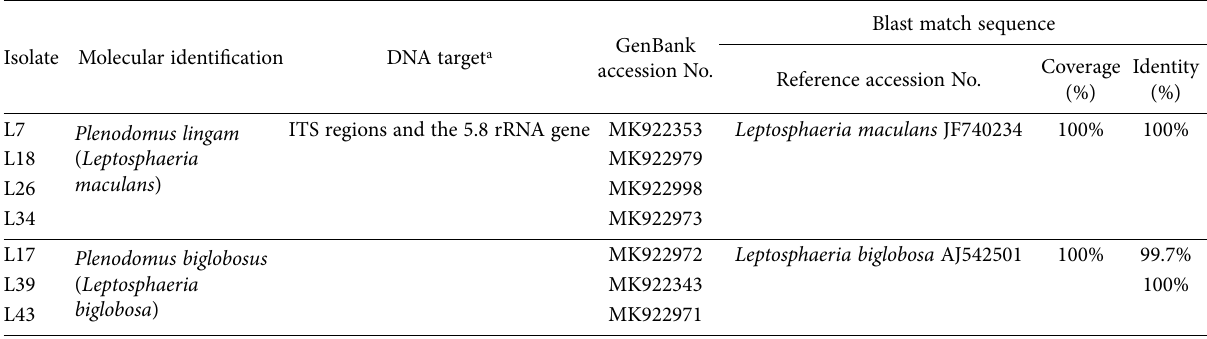
Table 2. Molecular identification and GenBank accession numbers of representative Plenodomus isolates assessed in this